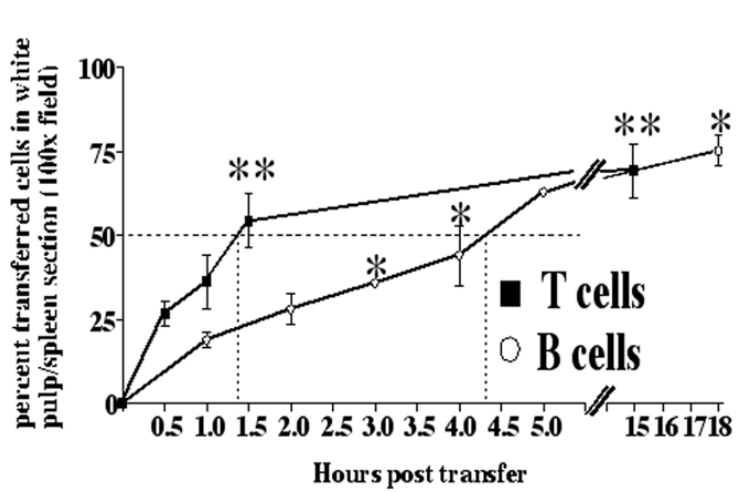
FIGURE 3. Comparison of T and B lymphocyte accumulation in the white pulp. The data represent the percent of transferred T cells or B cells per high powered field (100 ⋅ ) that are located within the MOMA-1–delineated white pulp. A minimum of three fields per spleen section, and a minimum of three spleen sections from two identically treated mice were analyzed for each time point for each cell type (mean ± SEM). The time at which 50% of the transferred cells in the spleen were located within the white pulp is indicated by the dotted line. Note that for T lymphocytes this is 1.4 h, whereas for B cells this is 4.3 h. * p < 0.05 vs. 1 h B cell timepoint; ** p < 0.05 vs. 30 min T cell